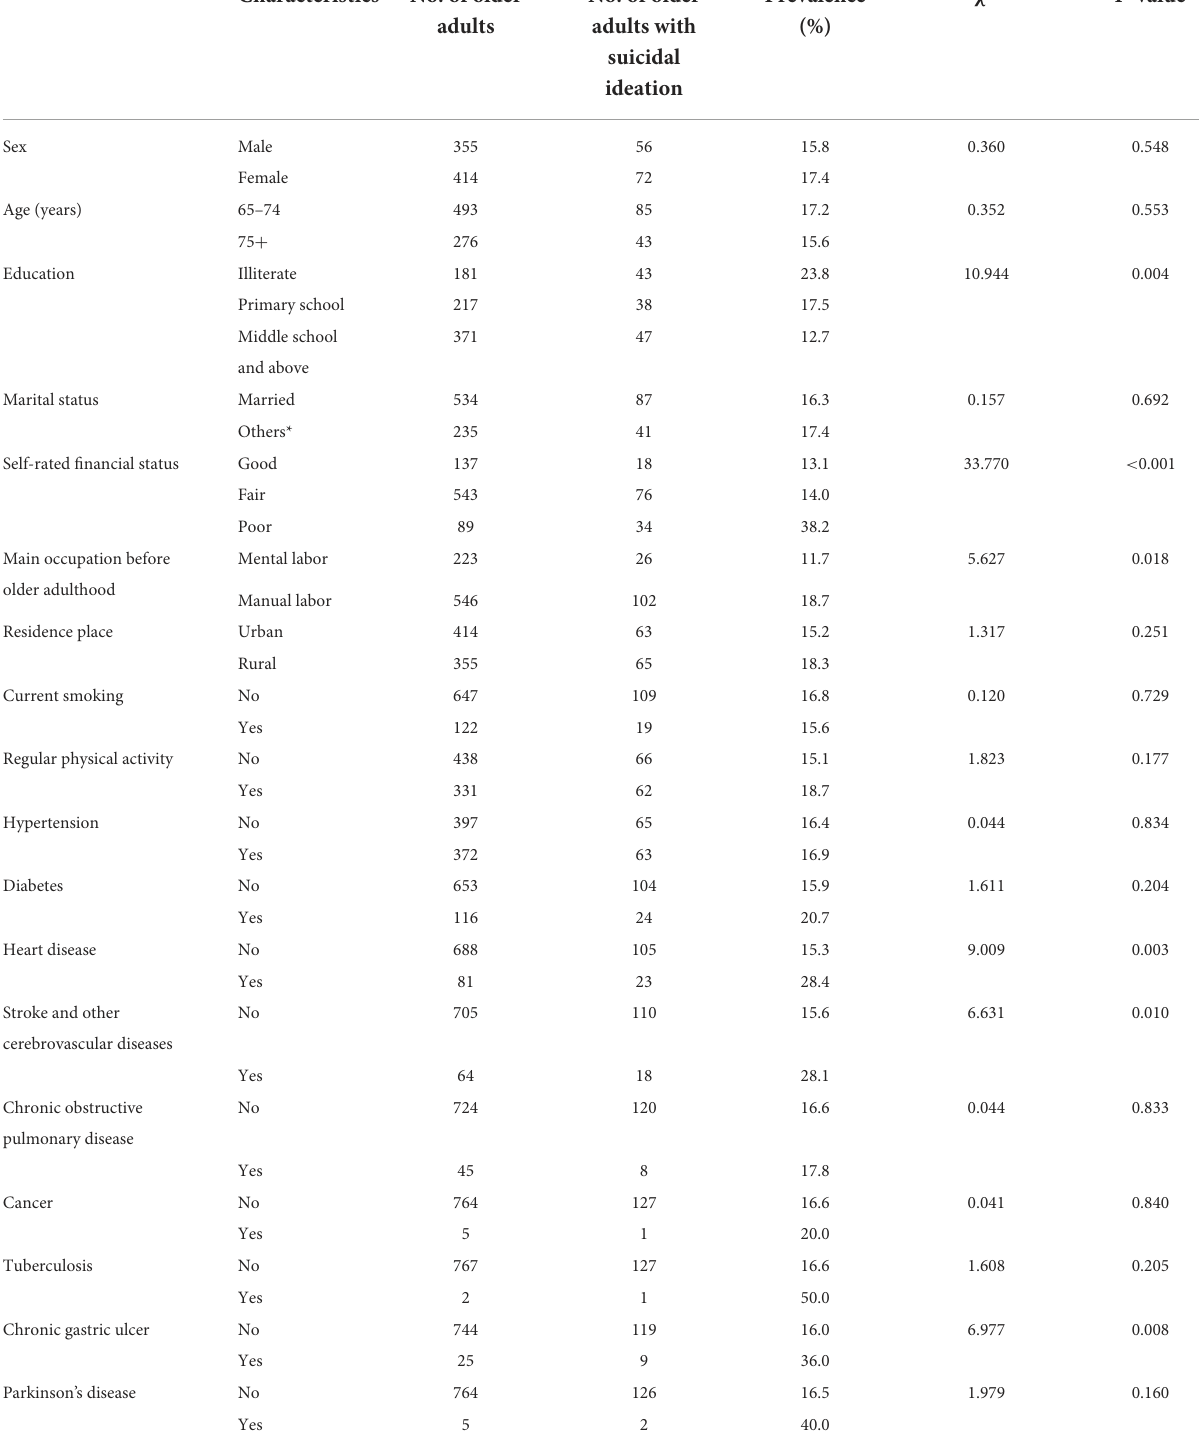
TABLE 1 Characteristics of the sample of older primary care patients and prevalence rates of suicidal ideation by sample characteristics. Characteristics No. of older No. of older adults adults with suicidal ideation